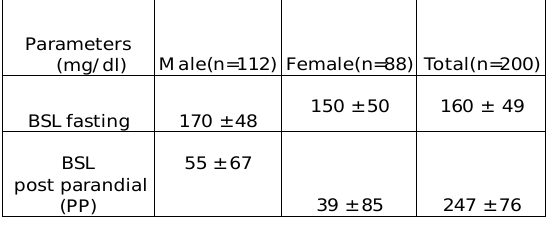
Table 1:Blood sugar level (BSL) status in Type II DM